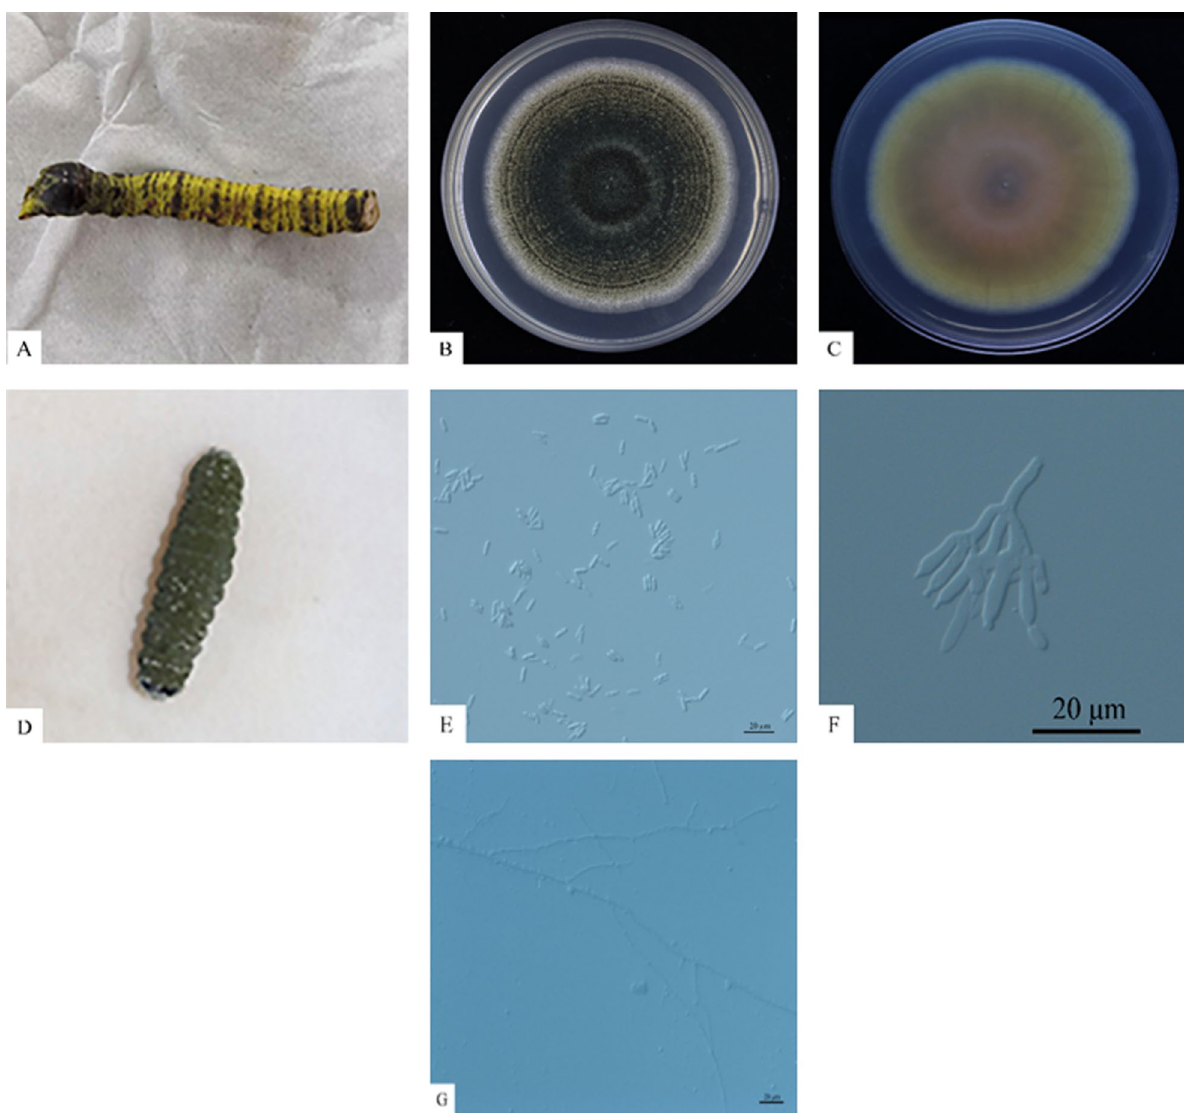
Fig. 1 Morphological characteristics of Metarhizium guizhouense Xct1. A Field worm samples; B Front of colony; C Back of colony; D Infected with fungus xct1 larvae; E Conidia; F Conidiophore; G